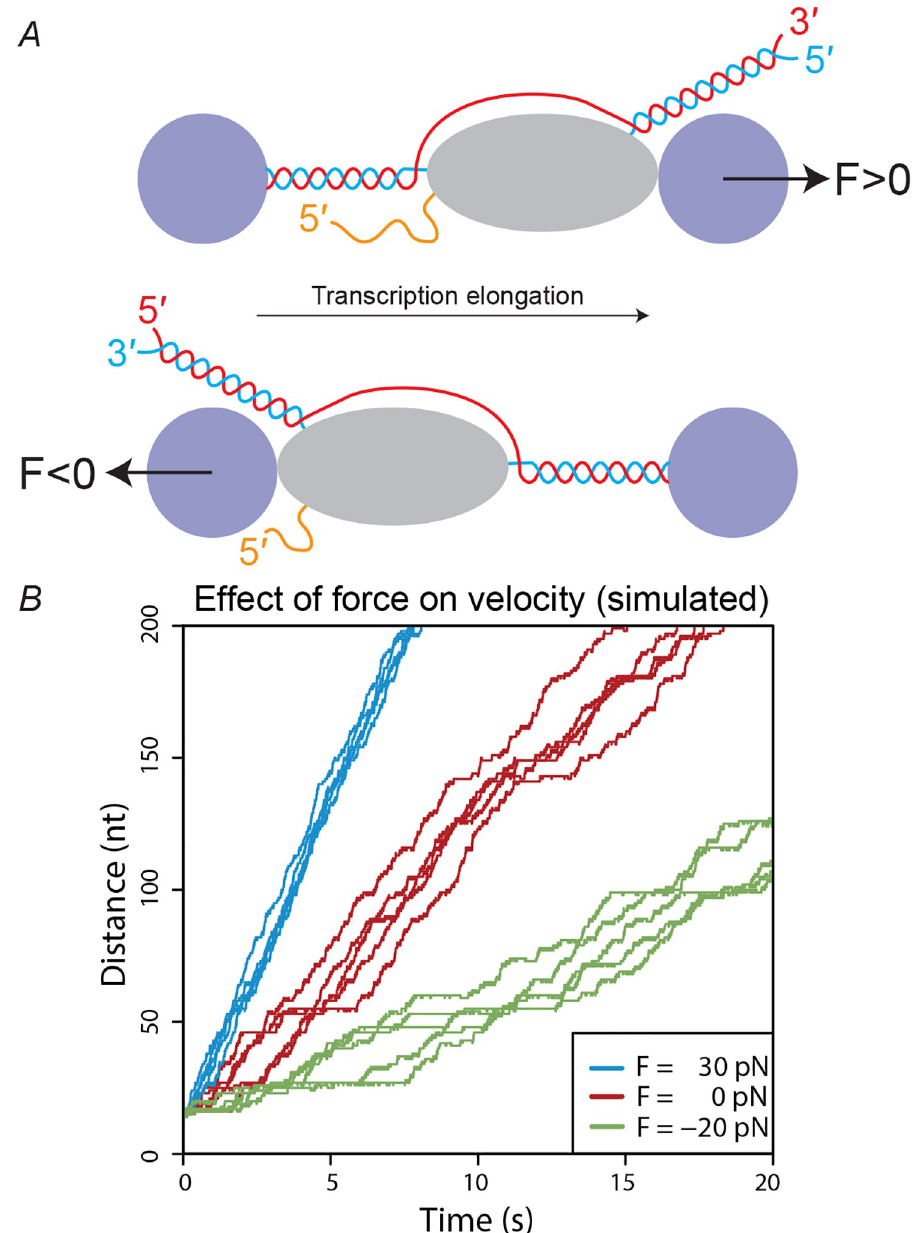
Fig 1. Effect of an applied force on elongation velocity. (A) Optical trapping setup showing dsDNA being transcribed by RNA polymerase (grey ellipse) into mRNA. Two polystyrene beads are tethered to the system allowing the application of force using optical tweezers. An assisting load F > 0 acts in the same direction as transcription (top) while a hindering load F < 0 acts in the opposing direction (bottom). Figure not to scale. (B) Schematic depiction of the effect of applying a force on RNA polymerase. Due to the stochastic nature of transcription at the single-molecule level, each experiment yields a different distance-time trajectory, even under the same applied